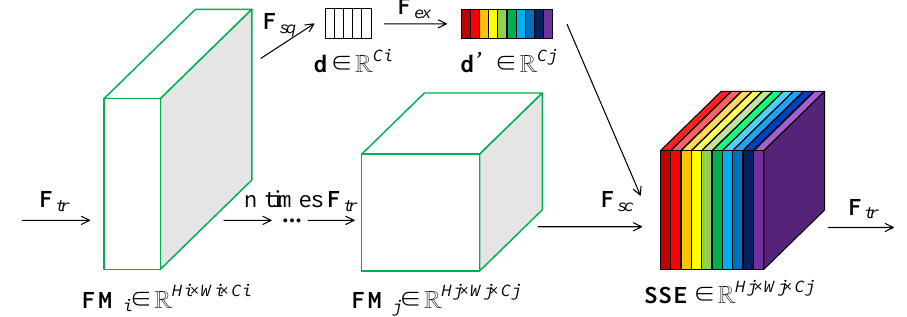
Figure 3. Structure of Skip-Squeeze-Excitation (SSE) Module.